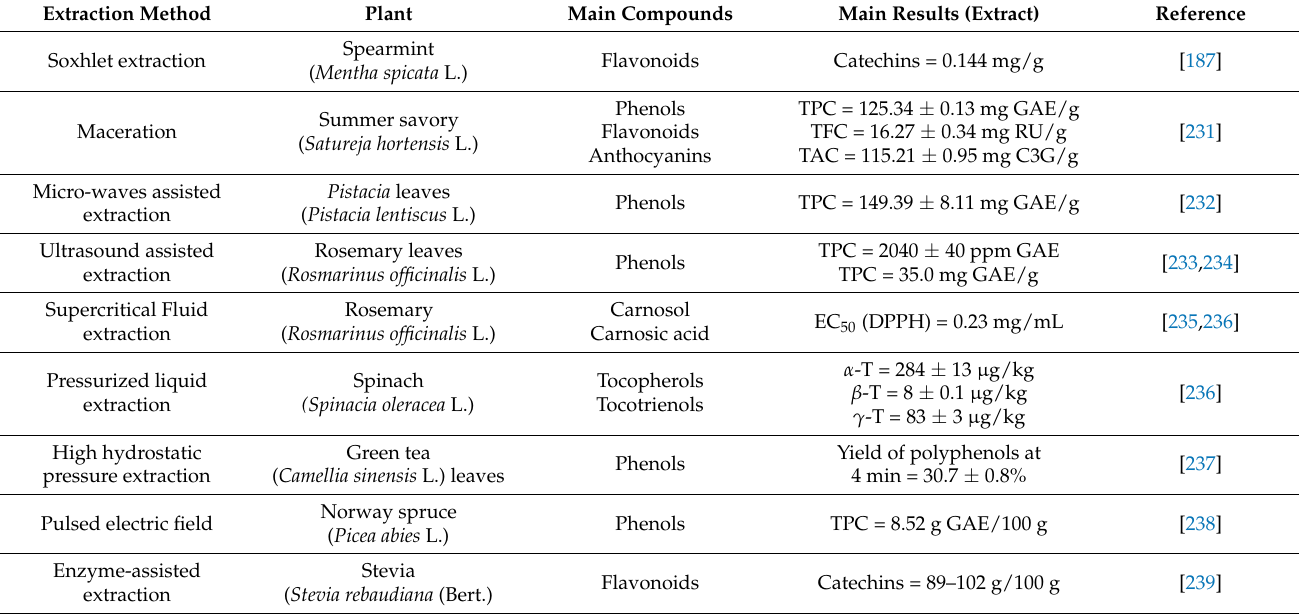
Table 4. Examples of extraction methods of natural